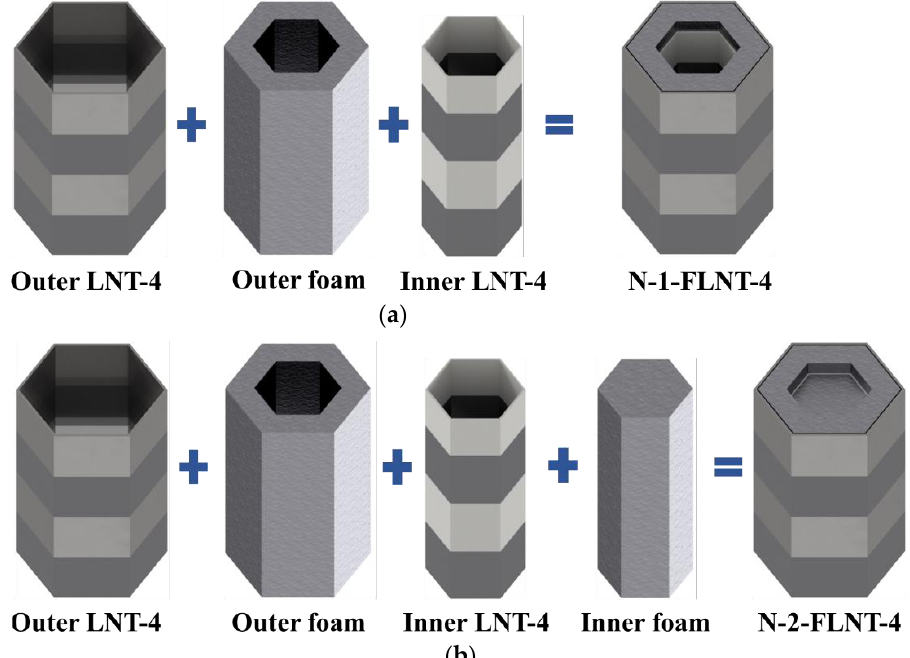
Figure 22. A novel nested foam-filled local surface nanocrystallization tube: ( a ) N-1-FLNT-4; ( b ) N-2-FLNT-4.